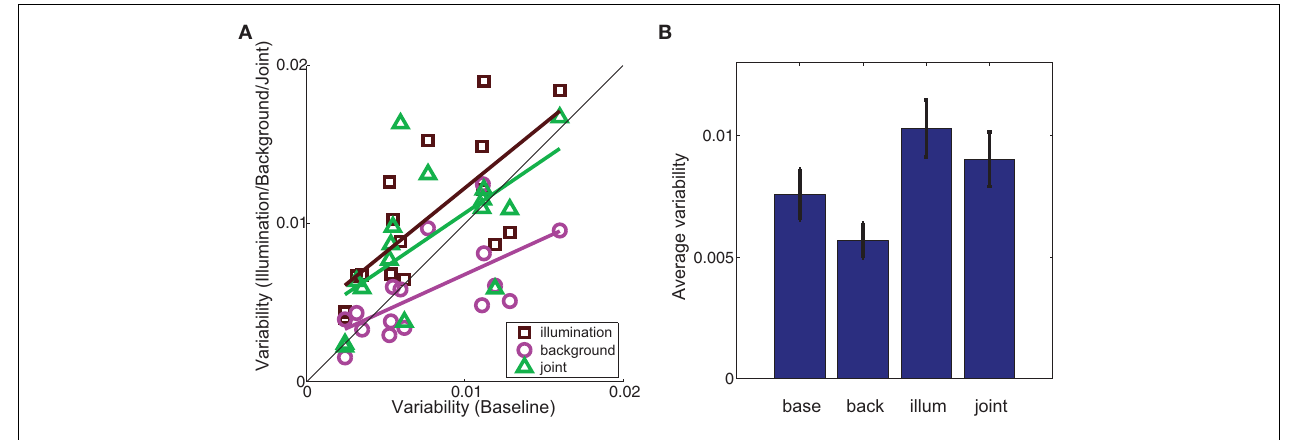
FIGURE 7 | (A) Variability of color matches in the illumination (brown squares), background (magenta circles) and joint (green triangles) conditions (y-axis) as a function of variability in the baseline condition (x-axis). Colored lines are best-fit to data in the least-squares sense. Black diagonal line indicates identity. (B) Variability in the